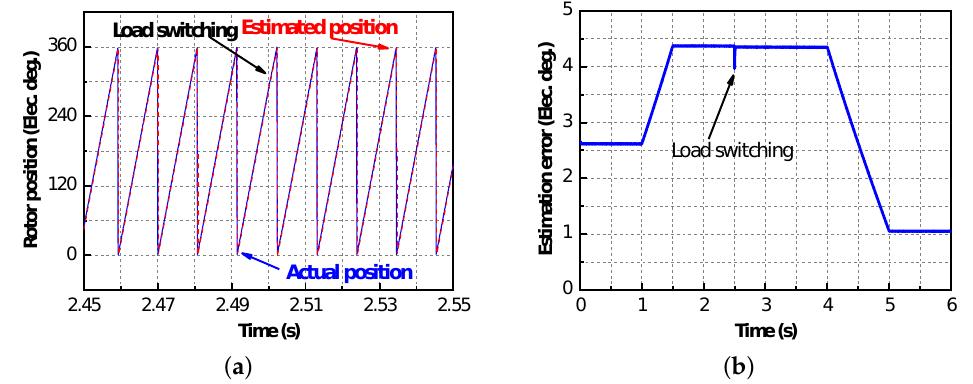
Figure 15. Simulation results of rotor position using the inductance matrix table. ( a ) Rotor position and ( b ) estimation error.